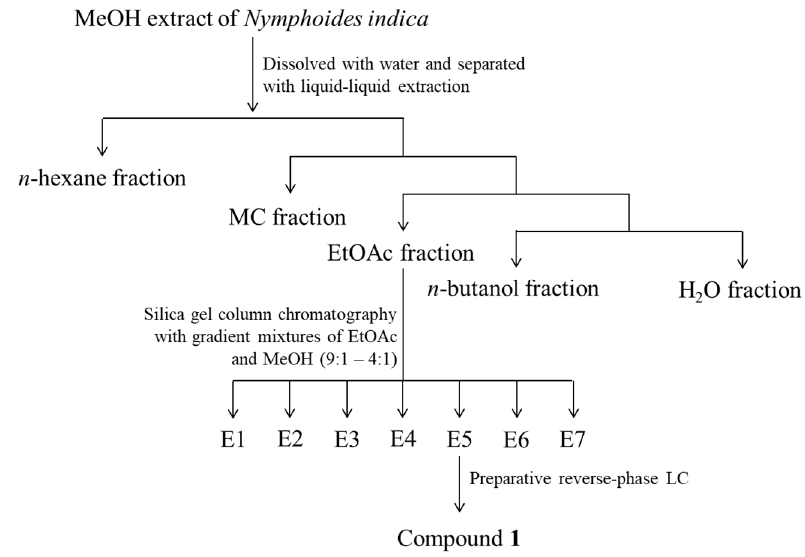
Figure 7. Separation procedure of methanol extract from Nymphoides indica .